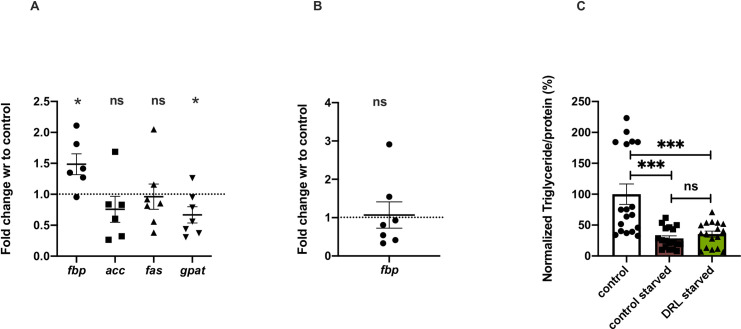
Larval fat body retention in adults results in obese flies.(A) Larval fat body marker fbp1 is present in 5 day old DRL flies. Shown is fbp1 mRNA levels in 5-day old control and DRL flies, data are shown as fold change in mRNA levels, values are normalised to control flies and fold change in DRL flies is shown [independent biological replicates = 6; p-value = 0.0340; acc [p-value = 0.3010] [independent biological replicates n = 6], fas [p-value = 0.8555] and gpat [p-value = 0.0450] gene expression in the 5 day old DRL flies. (B) fbp1 levels in the larvae remain unchanged [independent biological replicates = 6; p-value = 0.8476] in the 3rd DRL larvae, normalised to rp49 mRNA level is shown [independent biological replicates = 7; Unpaired Students t-test with Welch Correction]. Data are shown as fold change in mRNA levels, values are normalised to control flies and fold change in DRL flies is shown. (C) Triglyceride levels are equal in control and DRL flies after starvation for 48 hours upon eclosion and transferred to normal vials for five days with normal control flies. Data is represented as the ratio of triglyceride to protein levels in %, normalized to 100% in fed control flies, in comparison % of triglyceride to protein ratio is shown for control and DRL flies starved for 48 hours and recovered for five days with normal food [independent biological replicates = 18; p-value between control fed and control starved is = 0.0001, p-value between control fed and DRL starved is = 0.0011 and p-value between control starved and DRL starved is = 0.3346; Mann-Whitney test]. [p-value *<0.05; ** <0.01,*** <0.001, **** <0.0001, data is presented as mean ± SEM].